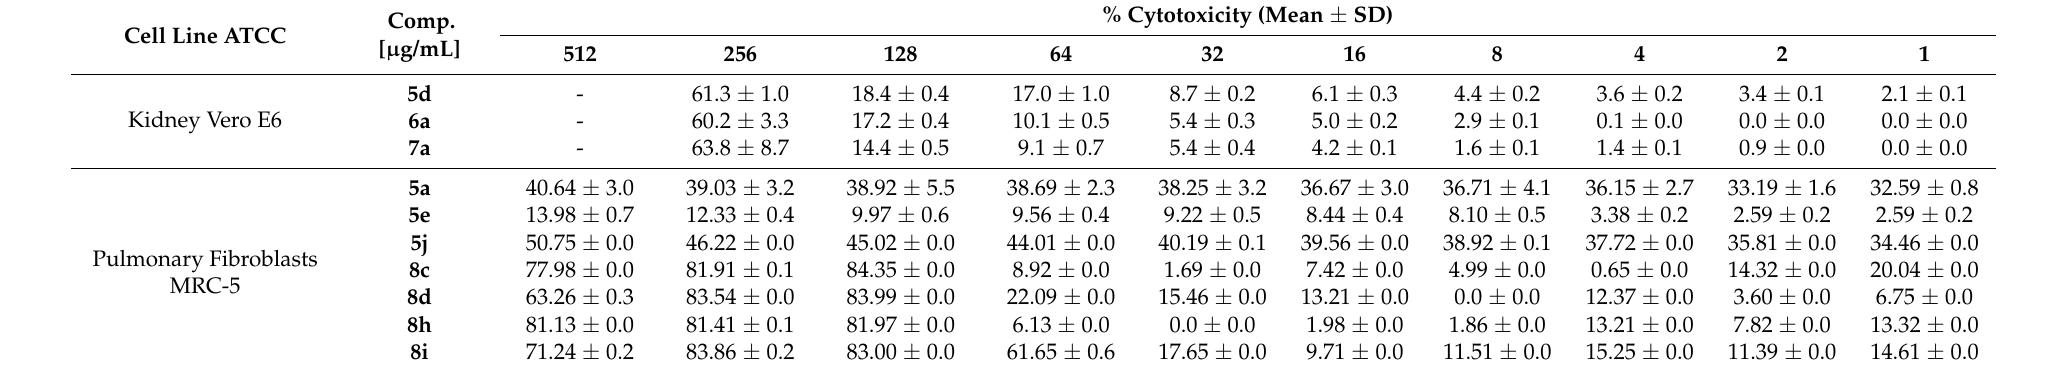
Table 4. Cytotoxicity (mean% ± SD) of benzoxazoles against the mammalian cell